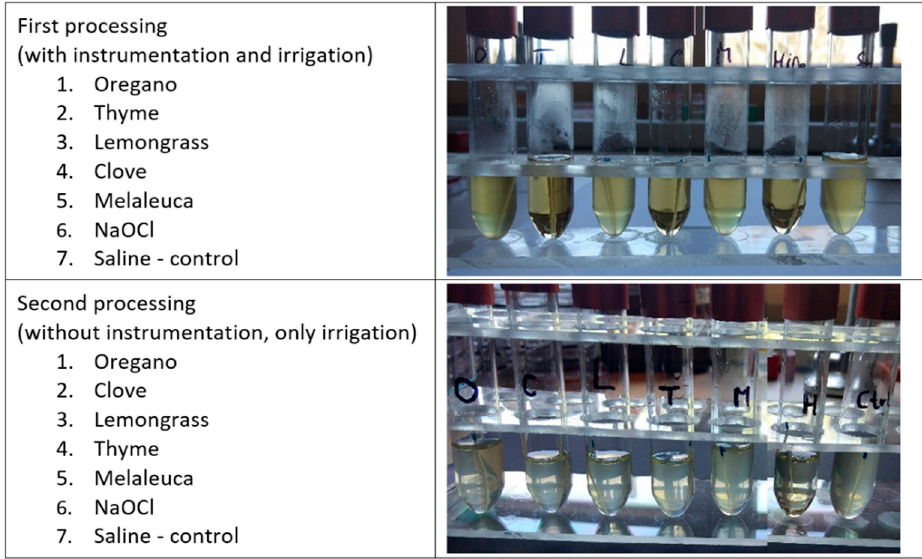
Figure 3. bacterial growth in enrichment media after irrigation with AqEOs, with and without in- strumentation.